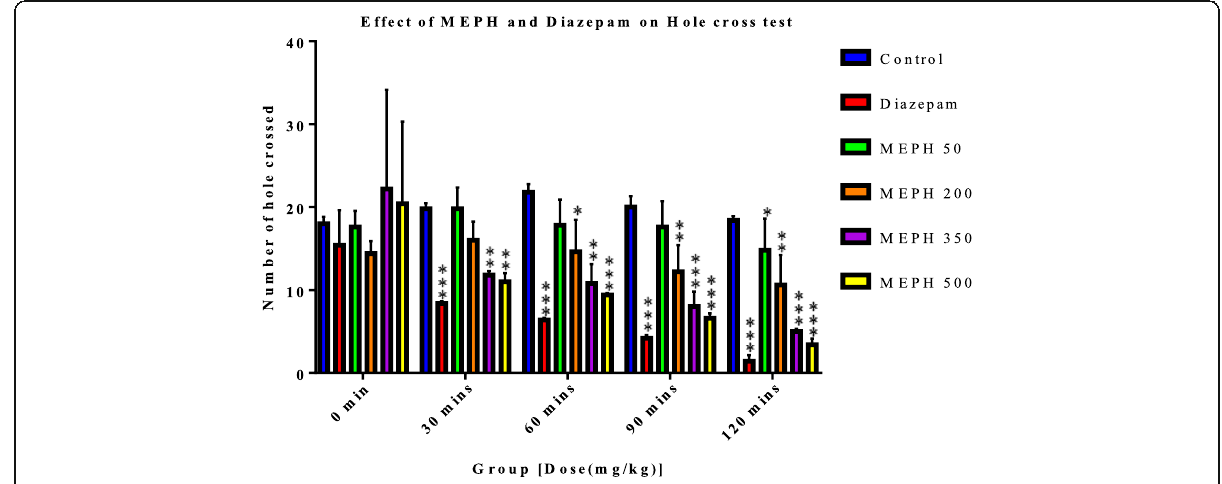
Fig. 2 The effect of MEPH on the hole cross test (number of hole crossed at 0 min, 30 mins, 60 mins, 90 mins and 120mins) in